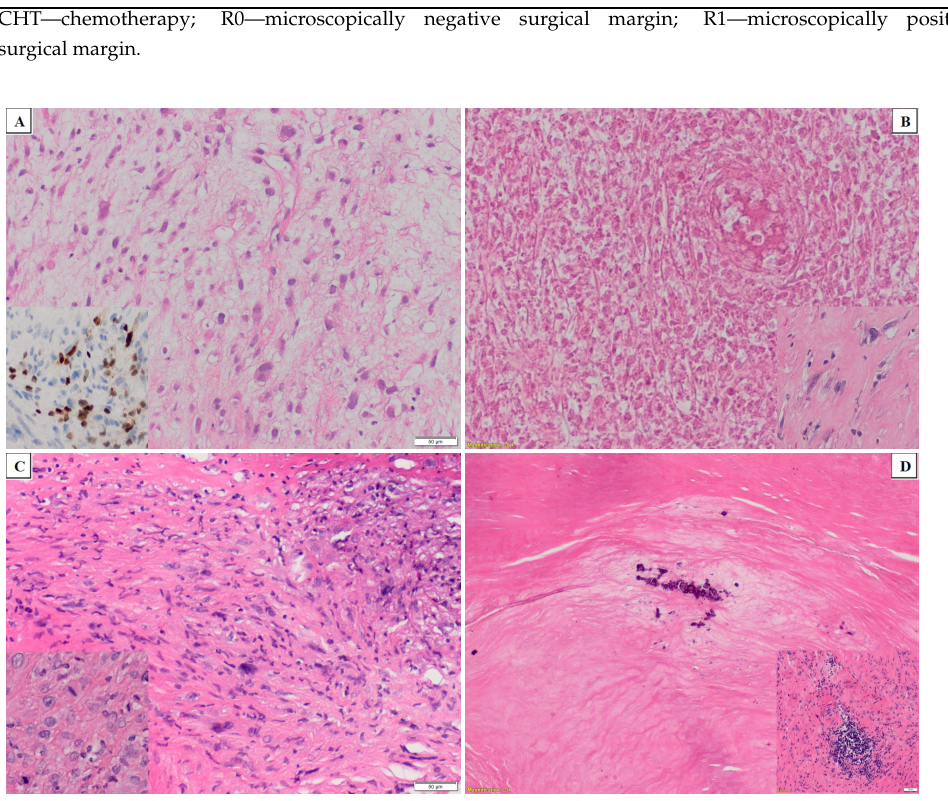
Figure 1. This is a figure. Schemes follow the same formatting. If there are multiple panels, they should be listed as: ( a ) Figure 2. Histological response to the treatment: ( A ) A pleomorphic rhabdomyosarcoma before Description of what is contained in the first panel. ( b ) Description of what is contained in the second panel. Figures should treatment confirmed by the myogenin expression (clone F5D, Daco, inlet); ( B ) diffuse necrotic changes be placed in the main text near to the first time they are cited. A caption on a single line should be centered. in the pleomorphic rhabdomyosarcoma after treatment with only single, degenerated neoplastic cells present (less than 1% of tumoral tissue, inlet); ( C ) biopsy of a high-grade, undifferentiated spindle cell Table 1. This is a table caption. Tables should be placed in the main text near to the first time they and focally pleomorphic sarcoma with brisk mitotic activity (inlet); ( D ) diffuse sclerosis with focal are cited. calcifications and scattered lymphocytic infiltrates in more fibrotic areas (inlet) in the undifferentiated sarcoma after